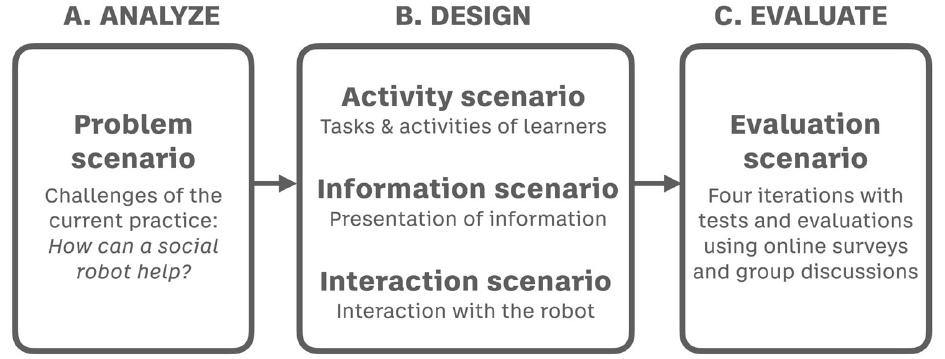
Figure 1. Scenario-Based Design (SBD) method applied to designing “Planning poker with NAO”.